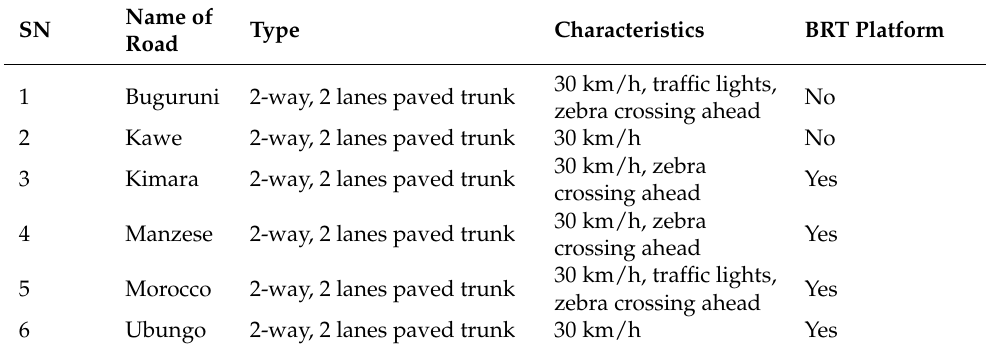
Table 1. Location of pedestrian bridges in Dar es